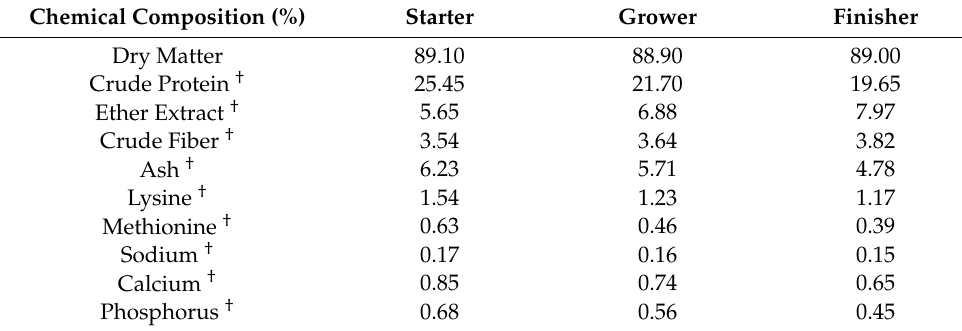
Table 1. Chemical composition of basal diet for